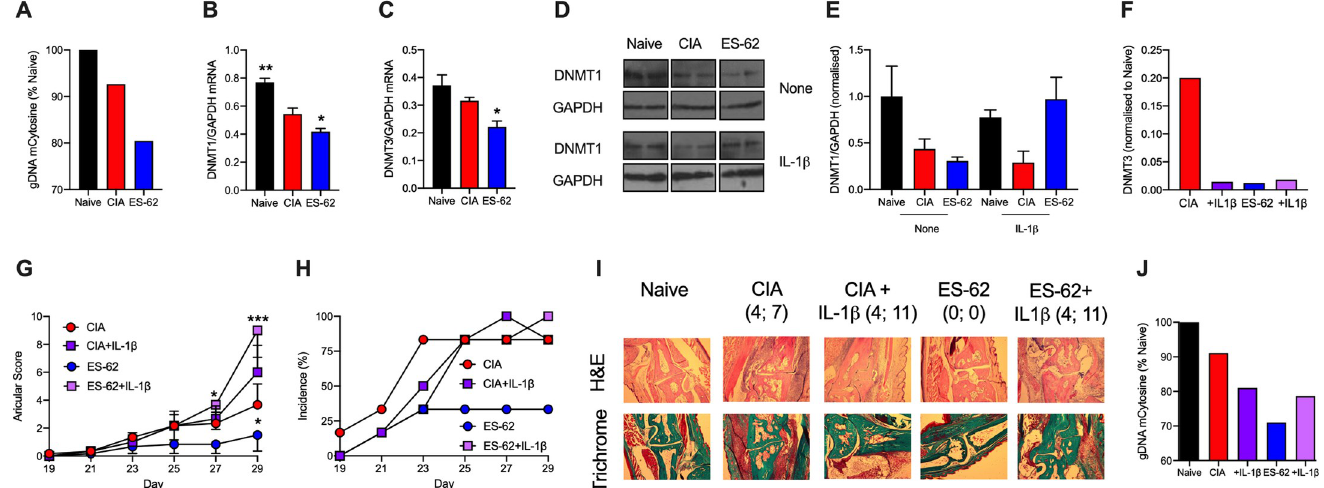
Fig 5. ES-62 induces a CIA-SF phenotype distinct from Na ï ve-SFs. SFs from Na ï ve, CIA and ES-62-CIA mice were assessed for their levels of ( A ) global DNA methylation and DNMT1 ( B ) and DNMT3 ( C ) mRNA expression, where data are mean values ± SEM, n = 3 independent cultures and � p < 0.05 and �� p < 0.01 are relative to CIA-SFs. ( D ) Western blot analysis of DNMT1 expression in independent cultures incubated in medium alone or containing IL-1 β for 24 h and the data (means ± range) quantitated by ImageJ software presented ( E ) as DNMT1/GAPDH ratios normalized to the “Na ï ve-None” controls. Pooled data from 6 independent cultures (normalized to Na ï ve controls) showed relative DNMT1 expression to be: Na ï ve, 1 ± 0.18; CIA, 0.24 ± 0.10 and ES-62, 0.26 ± 0.06, where ��� p < 0.001 for Na ï ve versus CIA or ES-62. ( F ) SFs from CIA- and ES-62-CIA mice were treated with medium or medium containing IL-1 β for 24 h and the levels of DNMT3 mRNA determined and normalized to Na ï ve controls. Throughout, SFs were pooled from individual mice to generate representative cohorts with articular scores: ( A and F ) CIA, 4.75 ± 1.31, n = 8 and ES-62-CIA, 0, n = 6; ( B-E ) CIA, 3.66 ± 1.5, n = 6 and ES-62-CIA, 1.5 ± 1.15 n = 6. ( G-J ) CIA was induced in mice treated with PBS (CIA) or ES-62 on days -2, 0 and 21 and then with PBS or IL-1 β (1 μ g/dose) twice-weekly from day 21 and articular scores ( G ) and incidence of pathology ( H ) monitored. The experiment was terminated prior to full pathology being established in the CIA control cohort due to the severity of joint disease in the IL-1 β treatment groups. ( G ) Articular scores are presented as mean values ± SEM with n = 6 mice/group where � p < 0.05 or ��� p < 0.001 are relative to the CIA group and ( H ) incidence represents the % mice displaying scores > 1. ( I) Representative sections of joint pathology displaying both the score of the joint shown and total articular score of the mouse presented. ( J) global methylation status of SFs from the indicated cohorts of this CIA ± IL-1 β model.